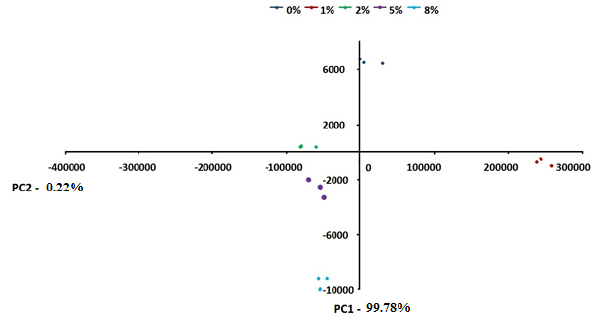
Figure 4: PCA analysis of the aromatic profiles of bread